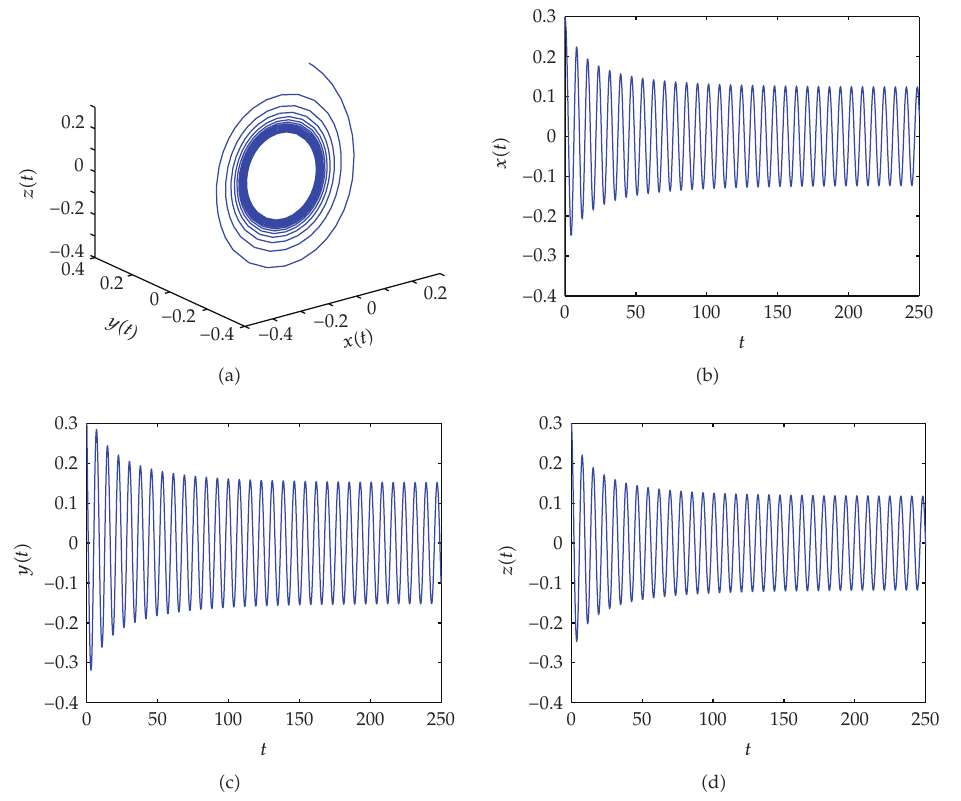
Figure 2: Phase portrait and waveform portraits of system (cid:4) 2.2 (cid:5) with τ (cid:6) 0 .